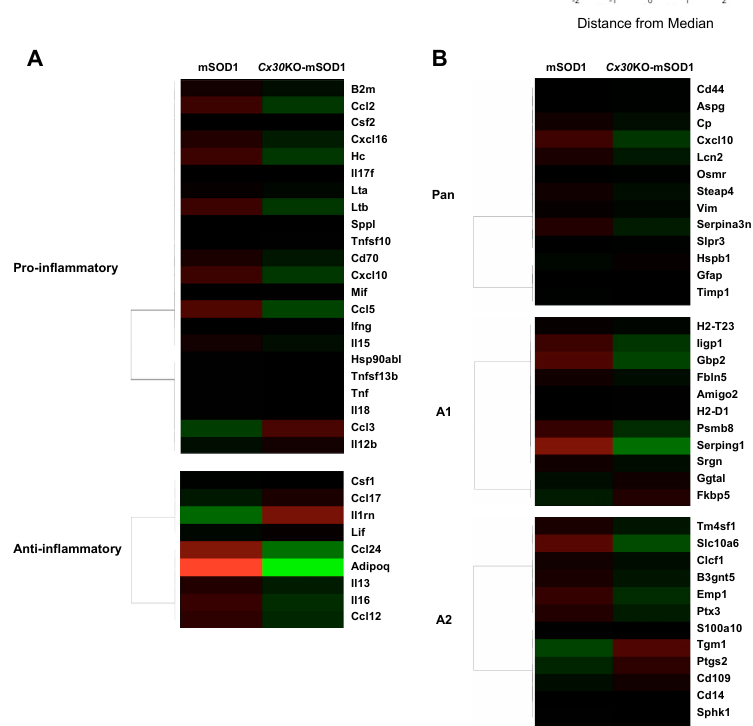
Figure 7. Microarray analysis of spinal cords from mSOD1 and Cx30 KO-mSOD1 mice. ( A ) Cluster analysis of gene expression arrays of pro-inflammatory and anti-inflammatory genes in the spinal cords of mSOD1 and Cx30 KO-mSOD1 mice. ( B ) Cluster analysis of gene expression arrays on pan- reactive, A1-specific, and A2-specific genes in the spinal cords of mSOD1 and Cx30 KO-mSOD1 mice.